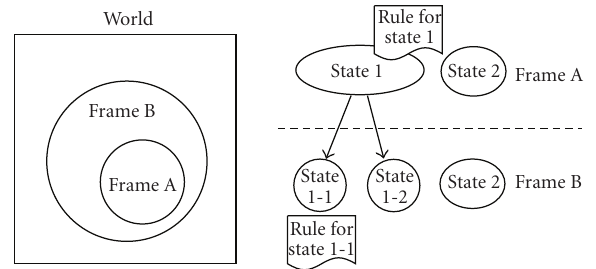
Figure 9: Antinomy between an existing rule and an accumulated rule. State 1 may be split into state 1-1 and state 1-2 when a new feature vector (frame B) is considered. There are no clear criteria to use to decide whether to select rule 1 or rule